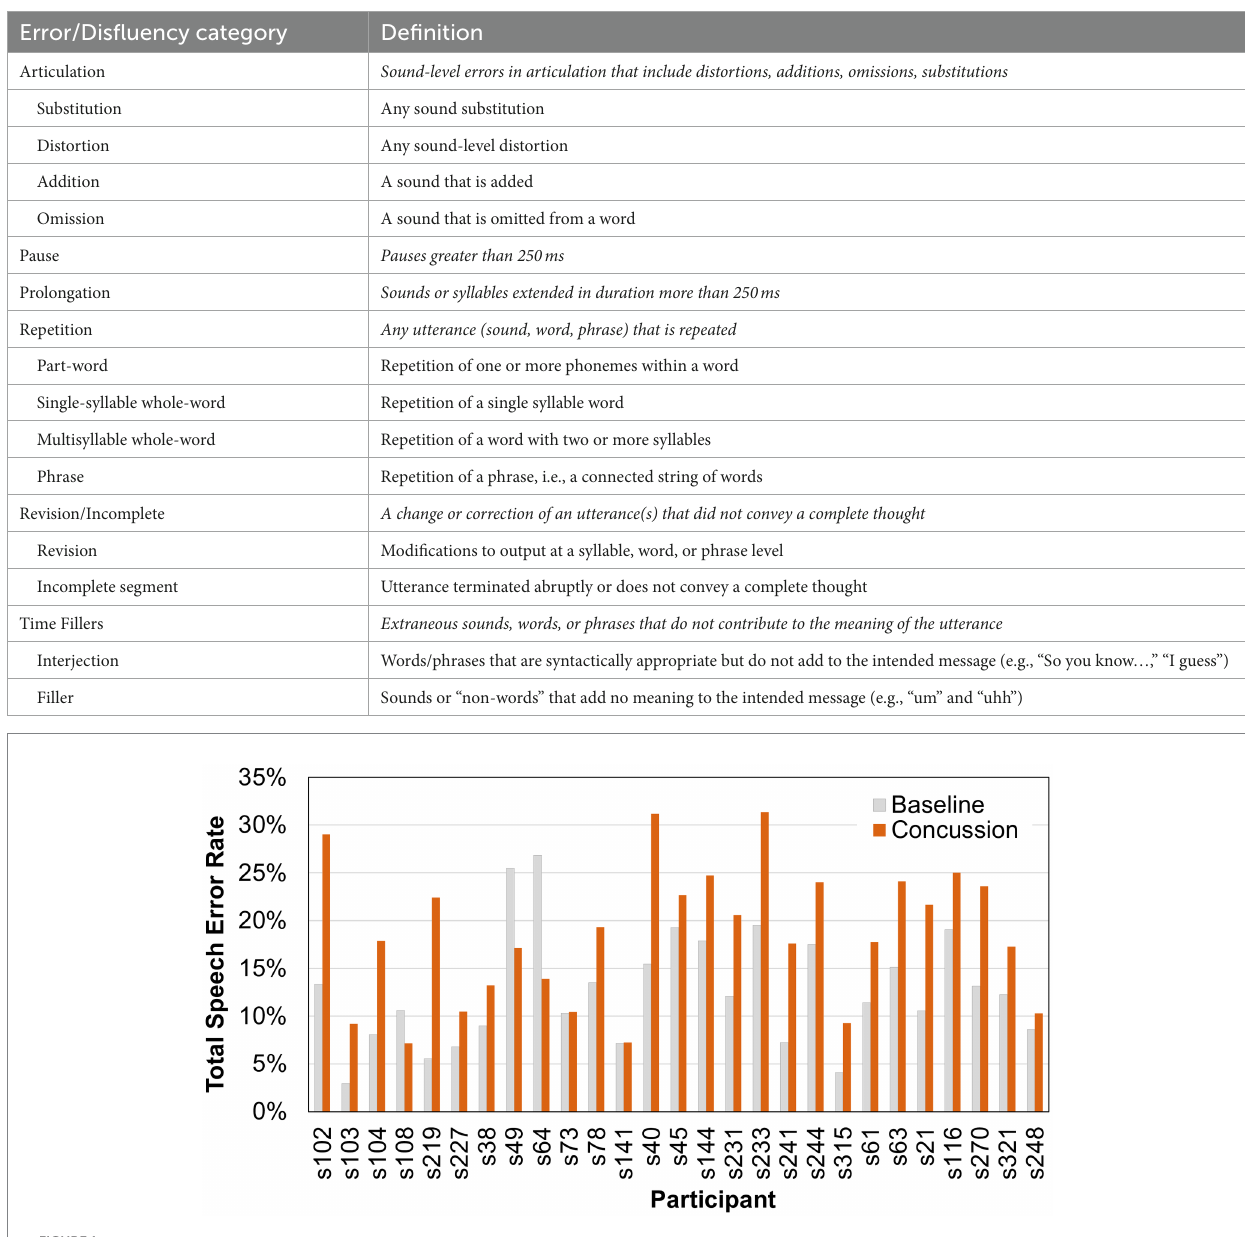
FIGURE 1 Total speech error rates (percent) for individual participants before and after a sports-related